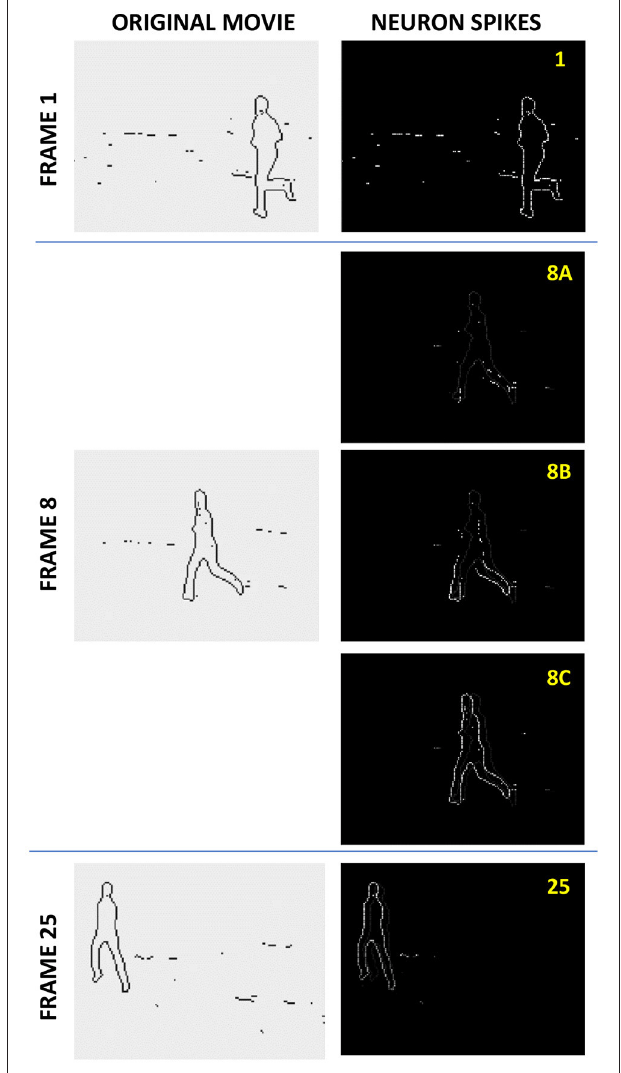
FIGURE 4 | The spike jitter effect at the asynchronous memory retrieval. A set of 4 different movies, with 25 frames each, each consisting of N 120 160 = × B/W pixels (obtained by applying edge detection to grayscale movies showing running humans), was recorded into a simulated ASTM of the same size (120 160 LIF cells), with connectivity M 31 31 – 1. The left column shows × = × three frames of one of the original movies: the initial Frame 1, an intermediate Frame 8, and the final Frame 25. The right column shows the brightness-coded snapshots of the spikes at the retrieval of this movie, with three middle snapshots, corresponding to Frame 8, separated by very small time intervals. As discussed in section Readout Options, the figure demonstrates the (rather counter-intuitive) effect of non-accumulating spike